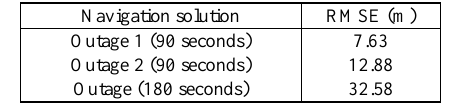
Table 1. Position RMSE for DR navigation solution method